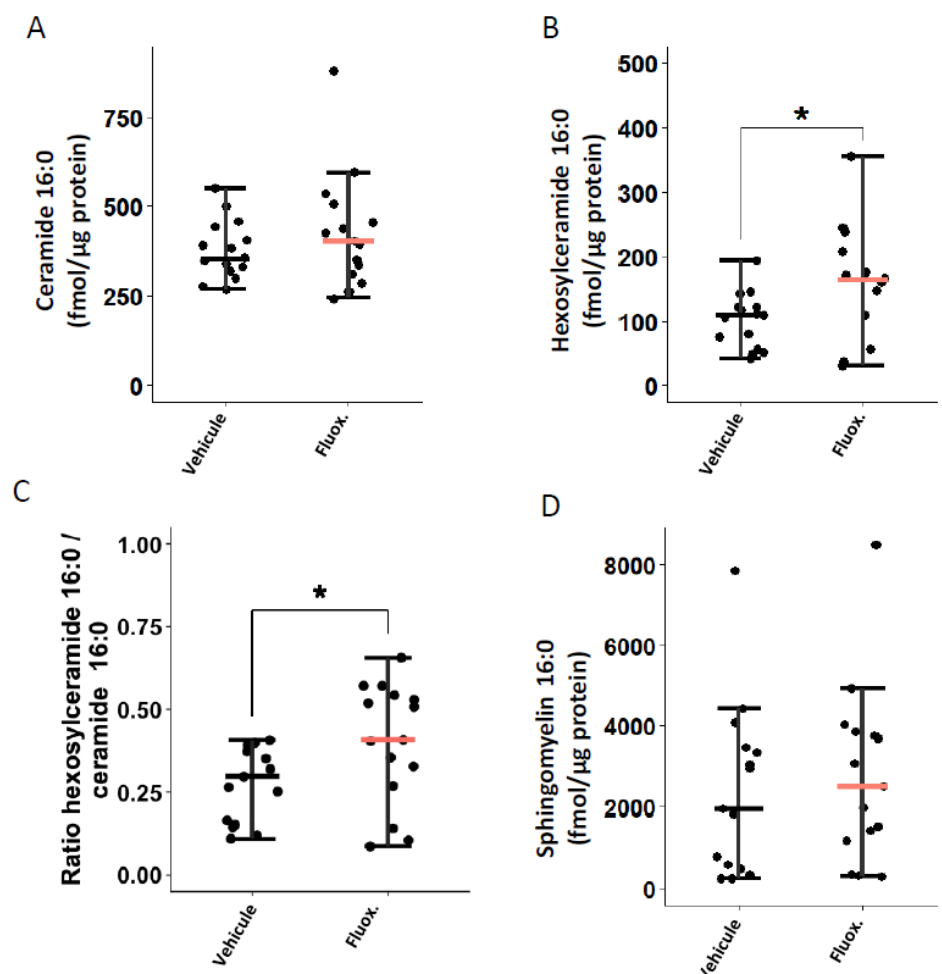
Figure 2. Fluoxetine effect on lung levels of ( A ) ceramide 16:0, ( B ) hexosylceramide 16:0, ( C ) hexo- sylceramide 16:0 / ceramide 16:0 ratio, and ( D ) sphingomyelin 16:0, at day 2 post-infection. *, p < 0.05.